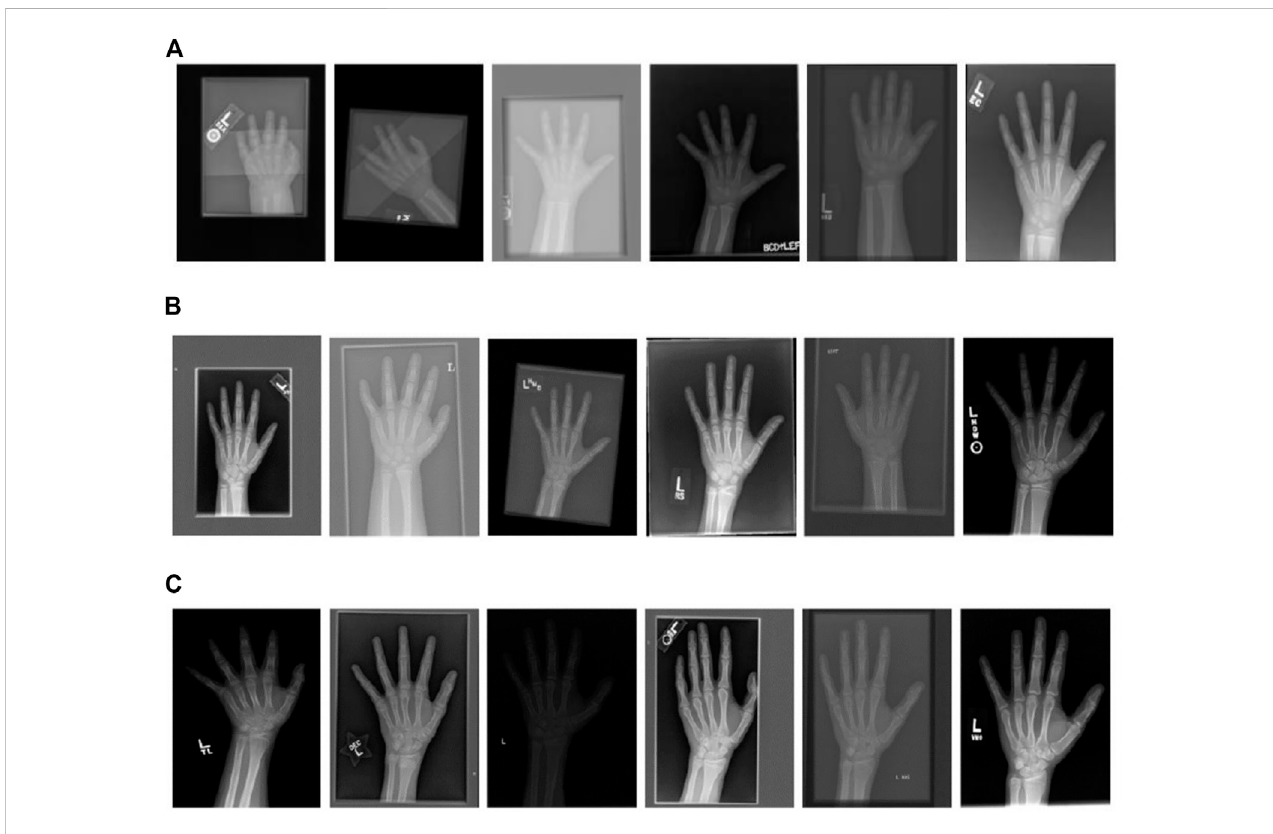
FIGURE 5 X-rays of hands based on (A) 1 – 6 years old; (B) 7 – 12 years old; (C) 13 – 18 years